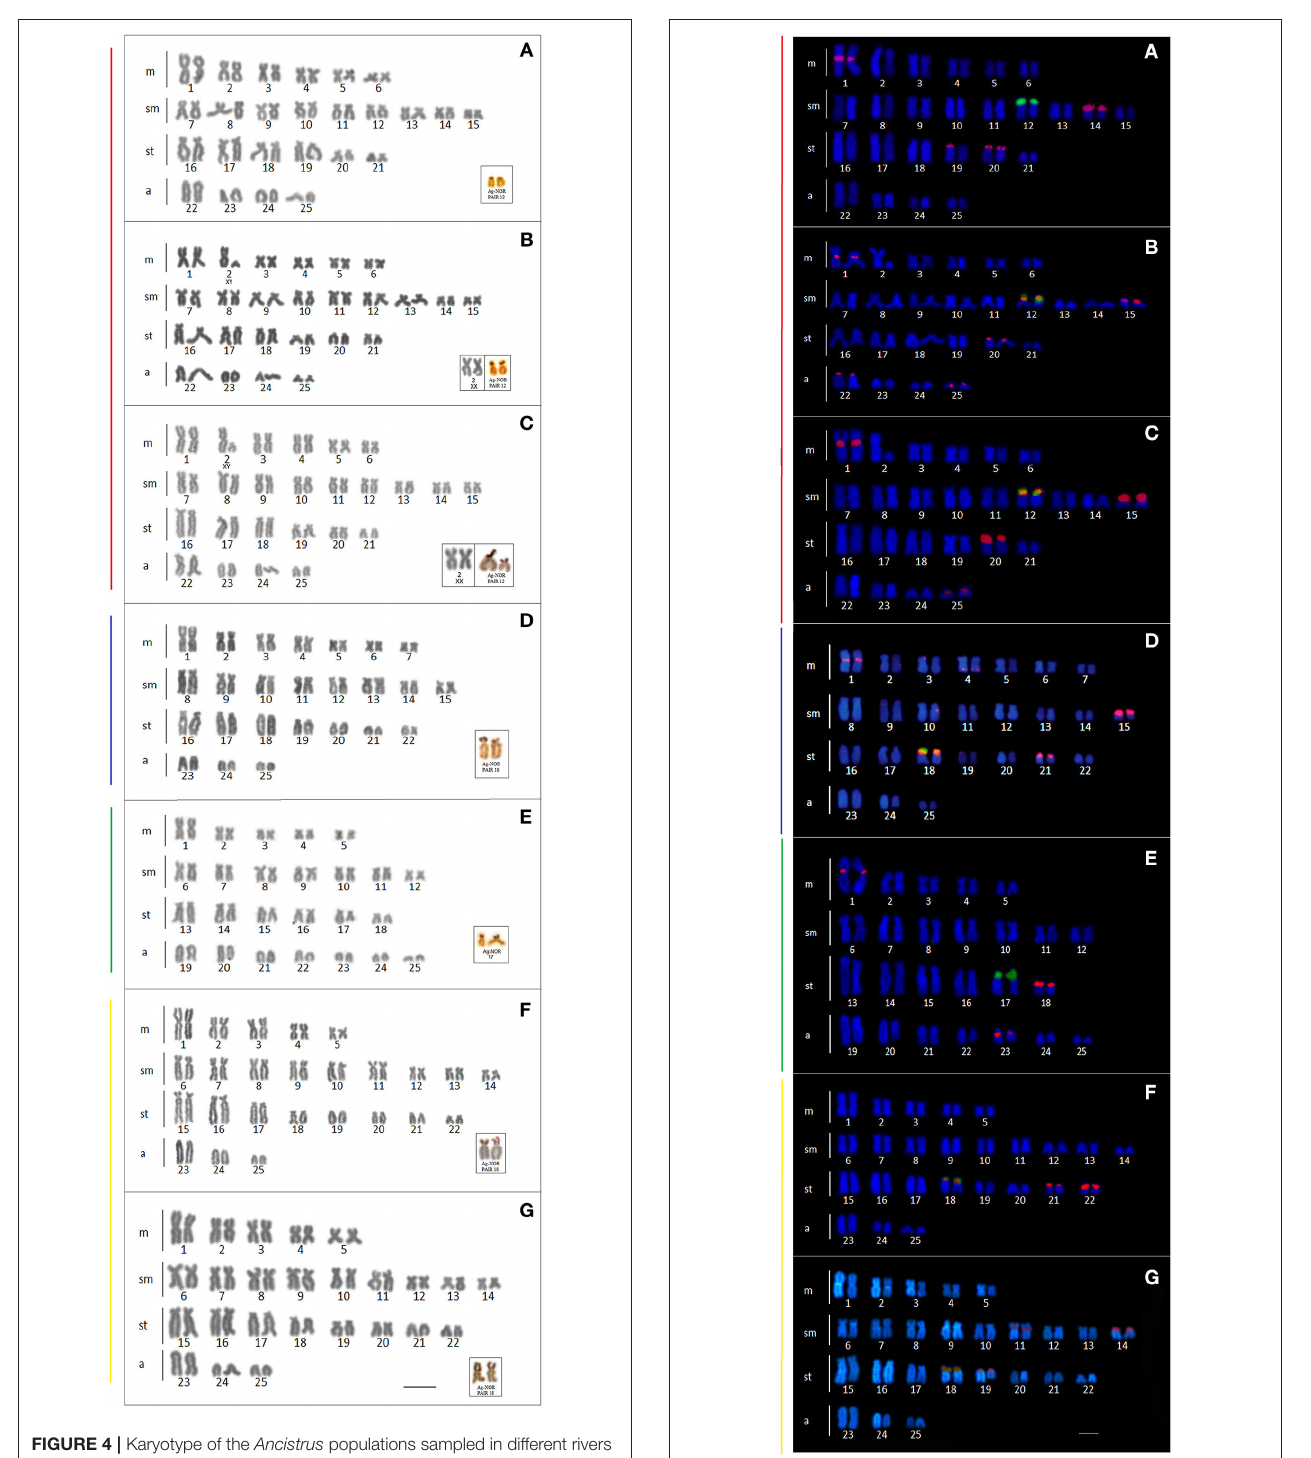
FIGURE 5 | Chromosomes of the Ancistrus populations of species after dual color-FISH showing the 5S rDNA (red) and 18S rDNA (green) sites. Each color of the side bars represents one of the evolutionary lineages recovered in the analysis, according to Figure 2 . (A) L1: Mourão River; (B) L2: 19 Stream; (C) L3: Keller River; (D) L6: São Francisco Verdadeiro River; (E) L8: Ancistrus cirrhosus ; (F) L9: Ocoí River; (G) L10: São Francisco Falso River. Bar = 10 µ